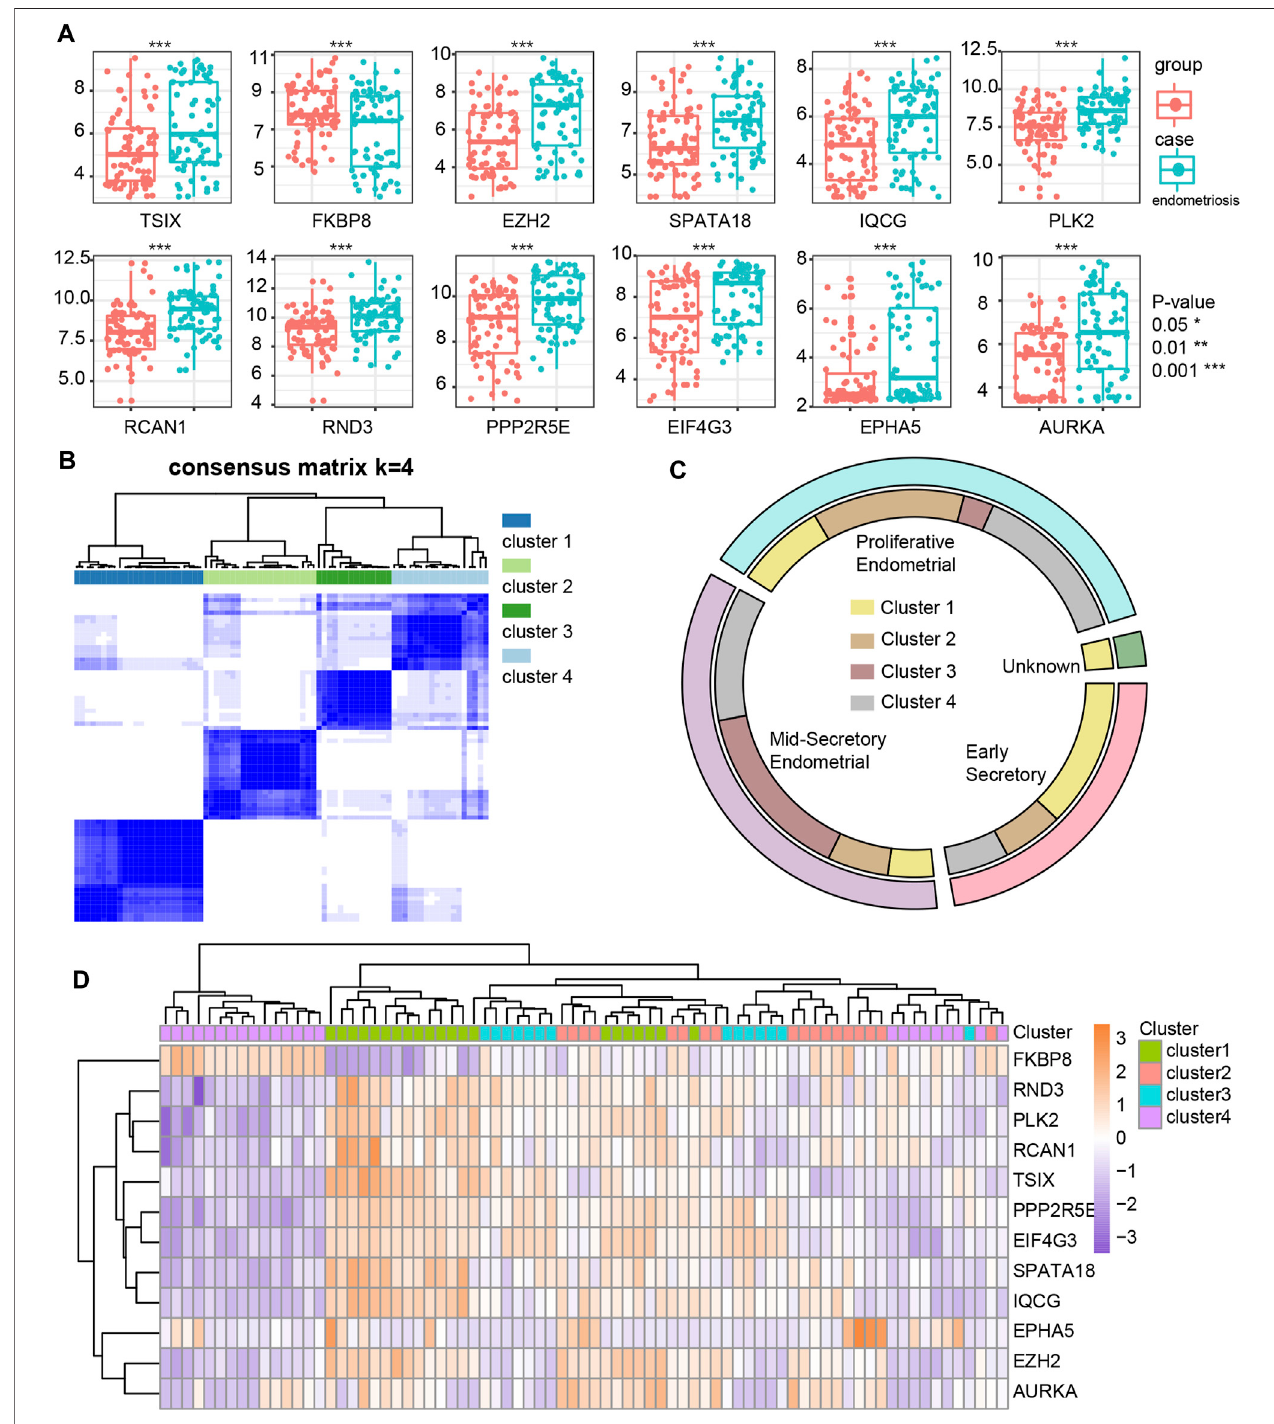
FIGURE 4 | Identi fi cation and differential expression of hub ATGs in GSE51981 (A) . Four new molecular subgroups were performed by consensus clustering analysis in endometriosis (B) . The distribution of the four new molecular subgroups in different periods of endometrium (C) . The expression of the 12 hub ATGs in four new molecular subgroups (D)